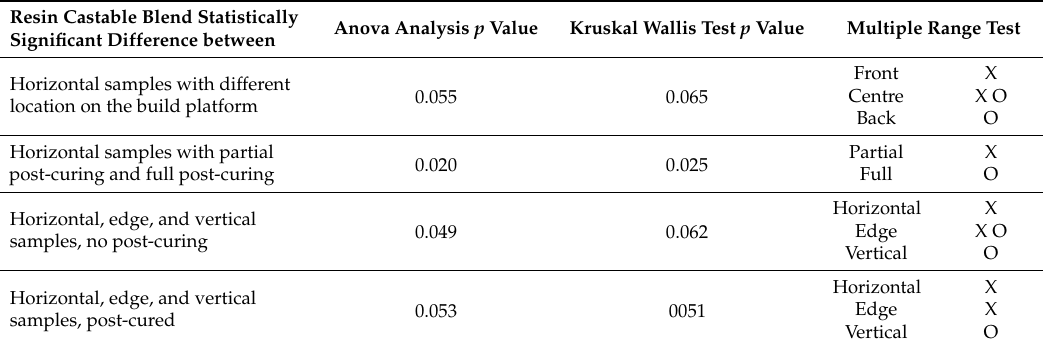
Figure 4. Castable resin in Projet 1200. Different build directions.